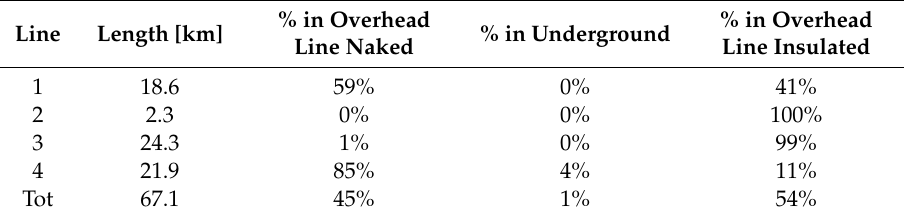
Table 1. MV lines characteristics.